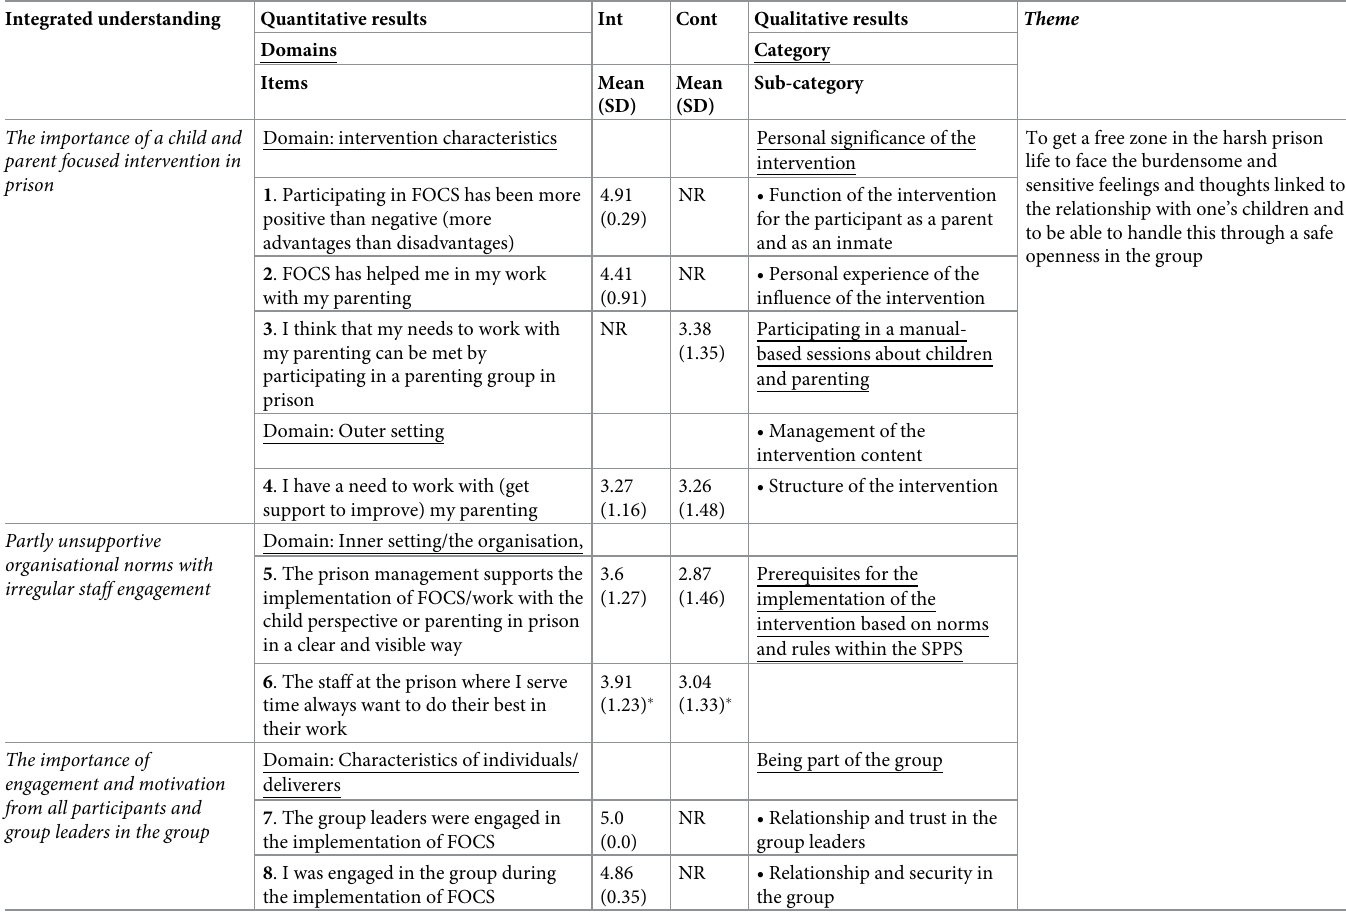
Table 3. Joint display with integrated understanding of qualitative and quantitative results